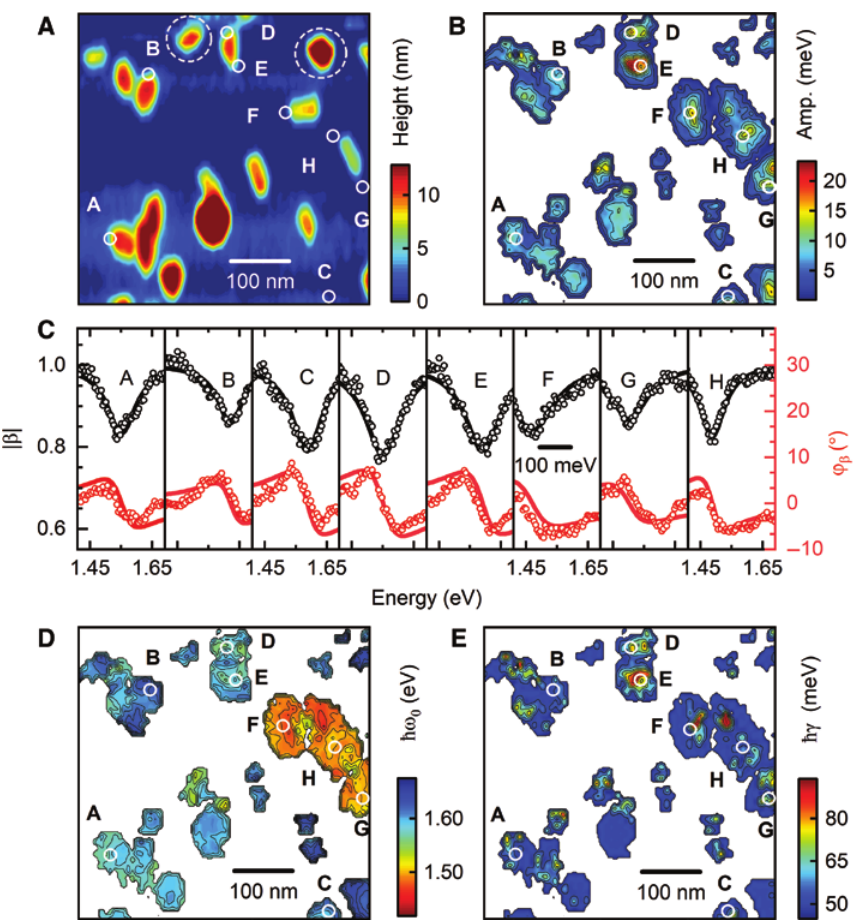
Figure 3: Spatial parameter maps of PNSI spectra of an ensemble of gold nanoparticles. (A) Topography image of the sample showing rod- and sphere-shaped nanoparticles of different sizes. The color scale is leveled off at a height of 13 nm. Capital letters mark the positions of the reconstructed spectra shown in (C), where the experimental data are shown as open circles and fits of the LSP resonance of the nanoparticles to a Lorentzian oscillator model as solid lines. (B, D, E) Parameter maps of the normalized amplitude (B), resonance energy (D), and linewidth (E) of the LSP resonance extracted from the PNSI spectra. At each 5 nm × 5 nm pixel of the scan, a full PNSI is recorded and fitted to a Lorentzian oscillator model. Parameters are given only at positions with sufficient nanoparticle near-field amplitude. An increase in scattering amplitude at the apices of the rod-like particles is the signature of the excitation of the longitudinal LSP mode. An increase in line width γ and a red shift of the resonance energy of the LSP resonance near the rod apices result from multiple scattering of near-field photons between the tip and the sample. The resonance energy of spherical particles [dashed circles in (A)] is blue-shifted out of the detection